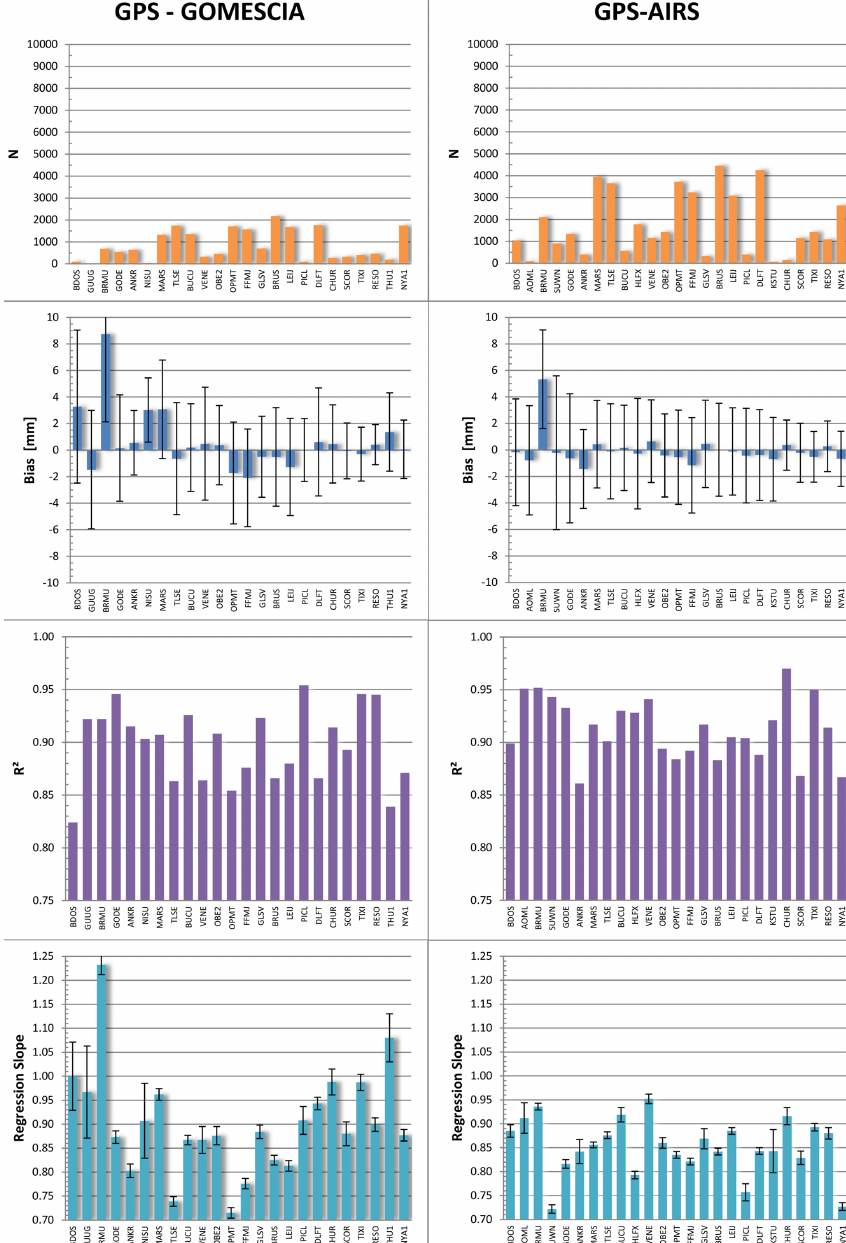
Figure 12. Column bar plots of scatter plot properties (count N , bias, R 2 and regression slope) of the different satellite instruments versus GPS for the selected sites. Sites are ordered with increasing latitude. The error bars represent the SD of the differences (bias panels) and the one-sigma uncertainty estimate of the regression